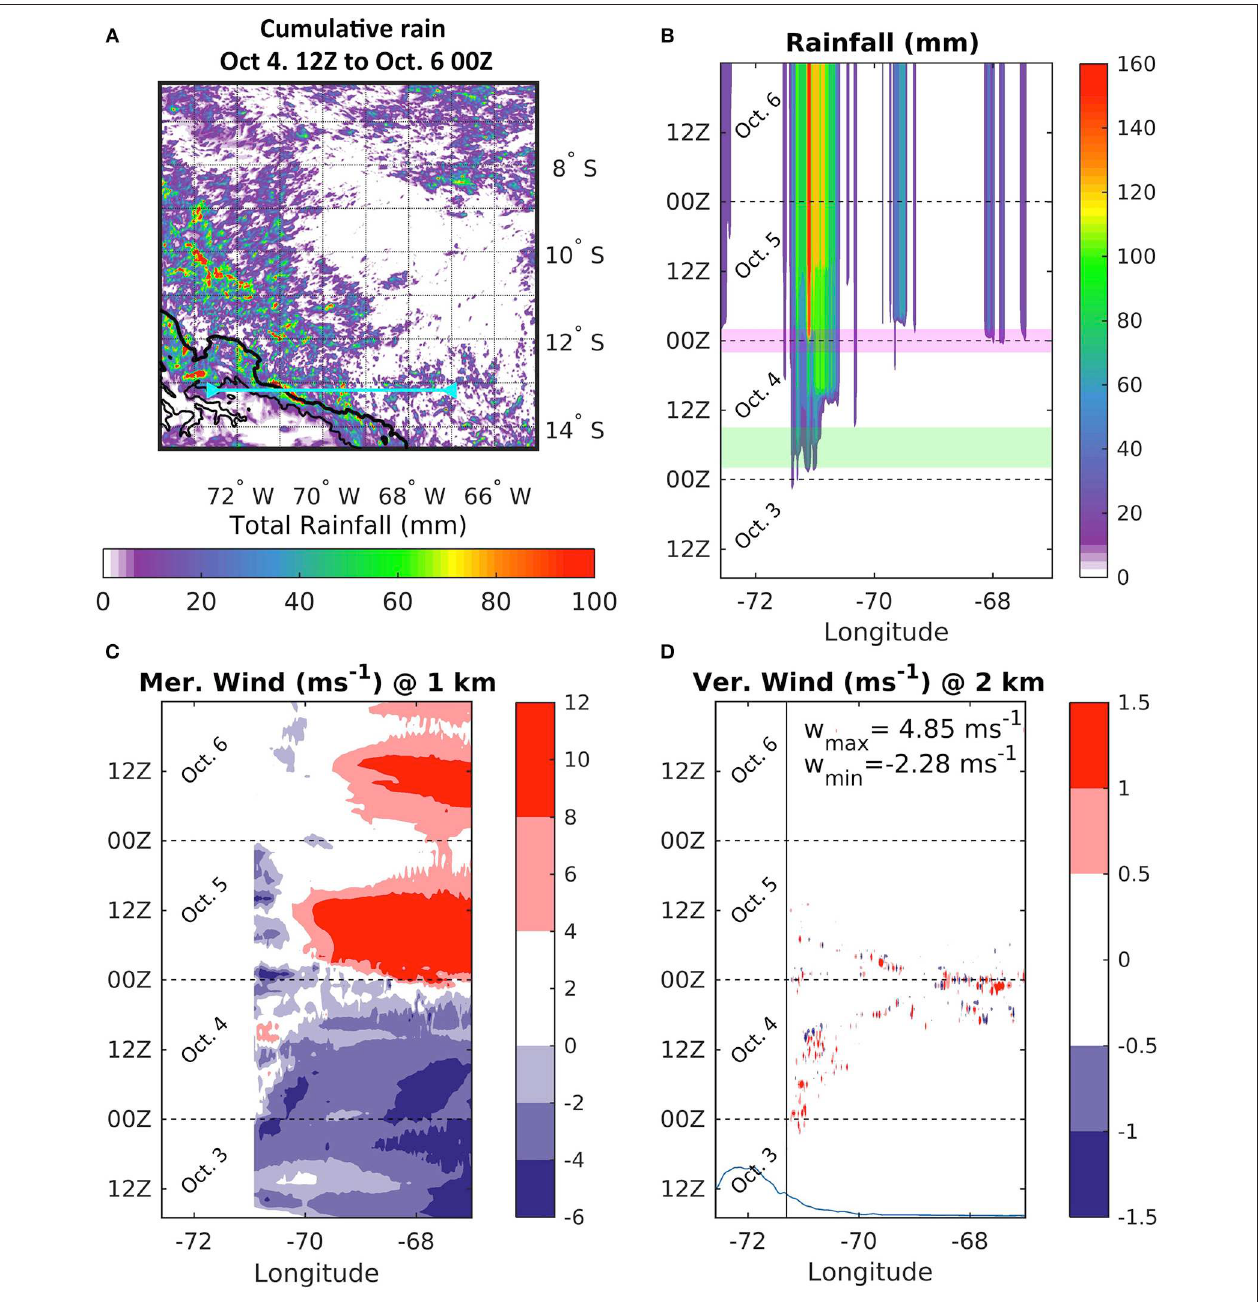
FIGURE 7 | (A) Simulated cumulative rainfall from the high resolution domain ( D 03, 1.2 km ) between Oct. 4, 12Z and Oct. 6, 00Z, 2013. The thick and thin black contour lines show the 1 km and 3.5 km topographic elevations, respectively; the cyan straight horizontal line marks the cross-section used in (B–D) . (B) Total cumulative rainfall in the cross section, purple shading in (B) indicates time of maximum rainfall intensity in model simulations, green shading in (B) indicates time of maximum rainfall intensity in the Madre de Dios network; (C) longitude-time diagram of meridional wind interpolated to 1 km AMSL; and (D) longitude-time diagram of vertical wind at 2 km AMSL. Blue line in (D) represents the terrain cross-section, and the black line is marked on the 2 km elevation contour.